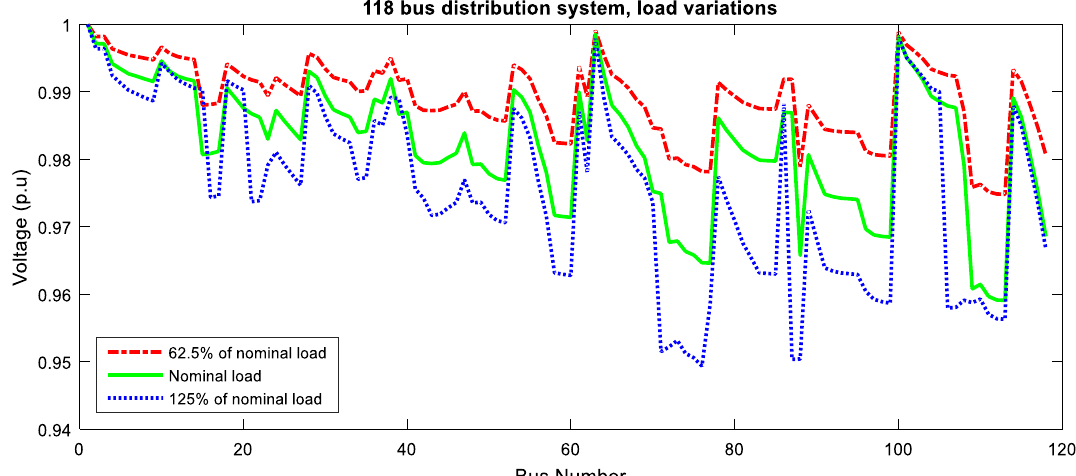
Figure 13. Voltage profile of 118-bus network with changing the demand via ITSOA with reconfiguration.